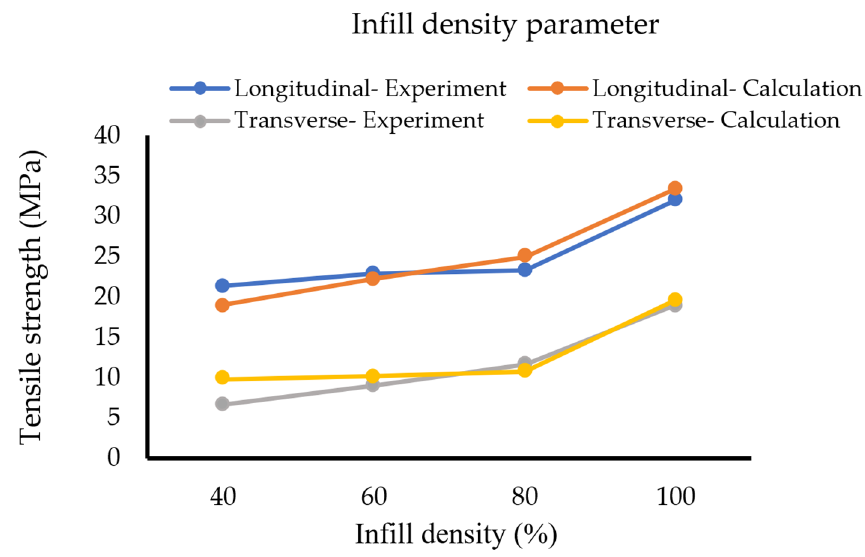
Figure 13. Infill density set (Method 2).